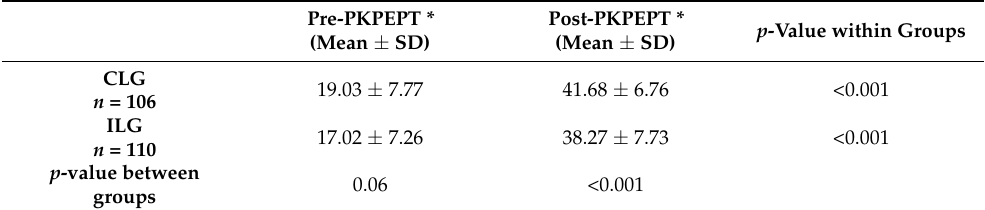
Table 3. Perception of knowledge regarding professional ethics after the training interventions in the studied groups.